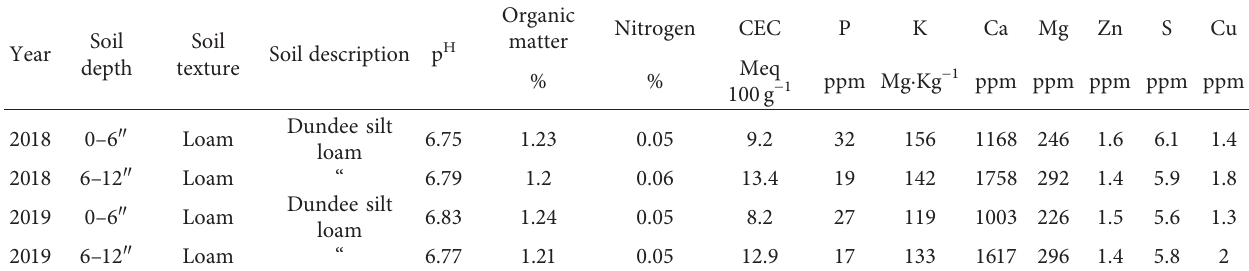
Table 1: Selected soil chemical properties of research fields used for studies in Stoneville, MS, USA, in 2018 and